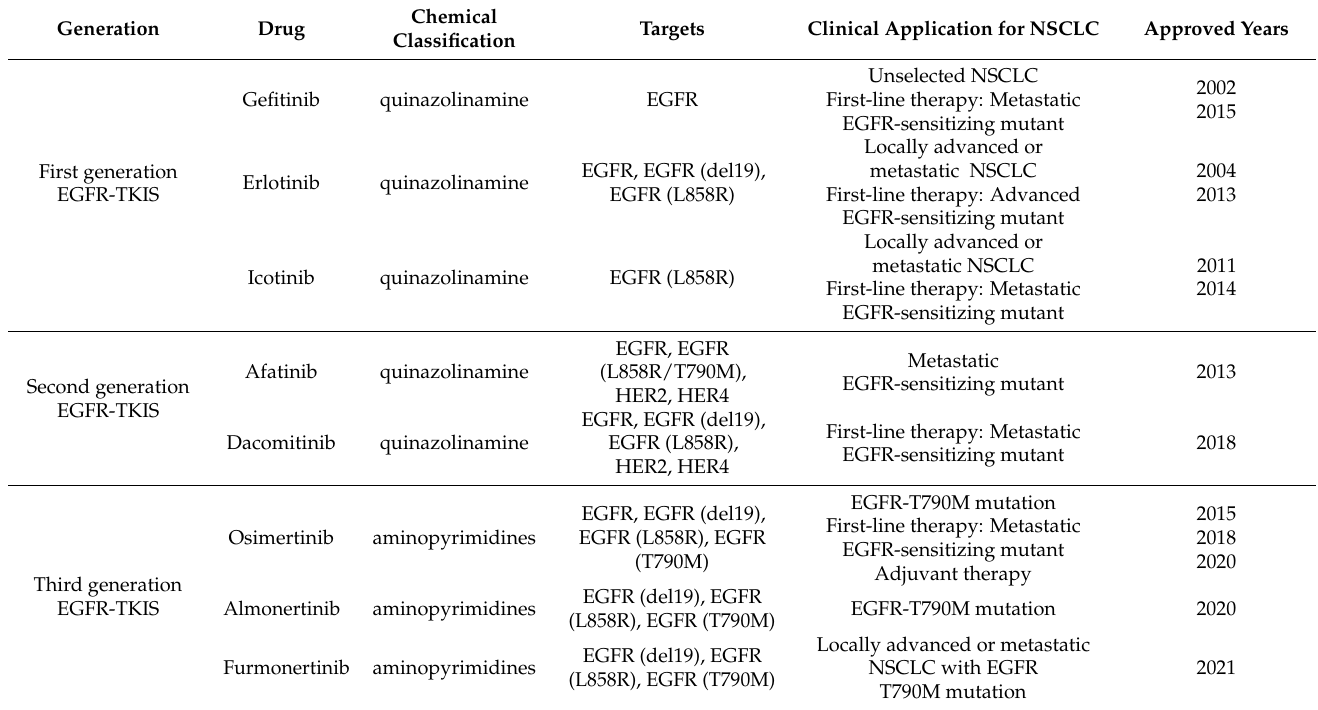
Table 1. Clinically used EGFR-TKIs in